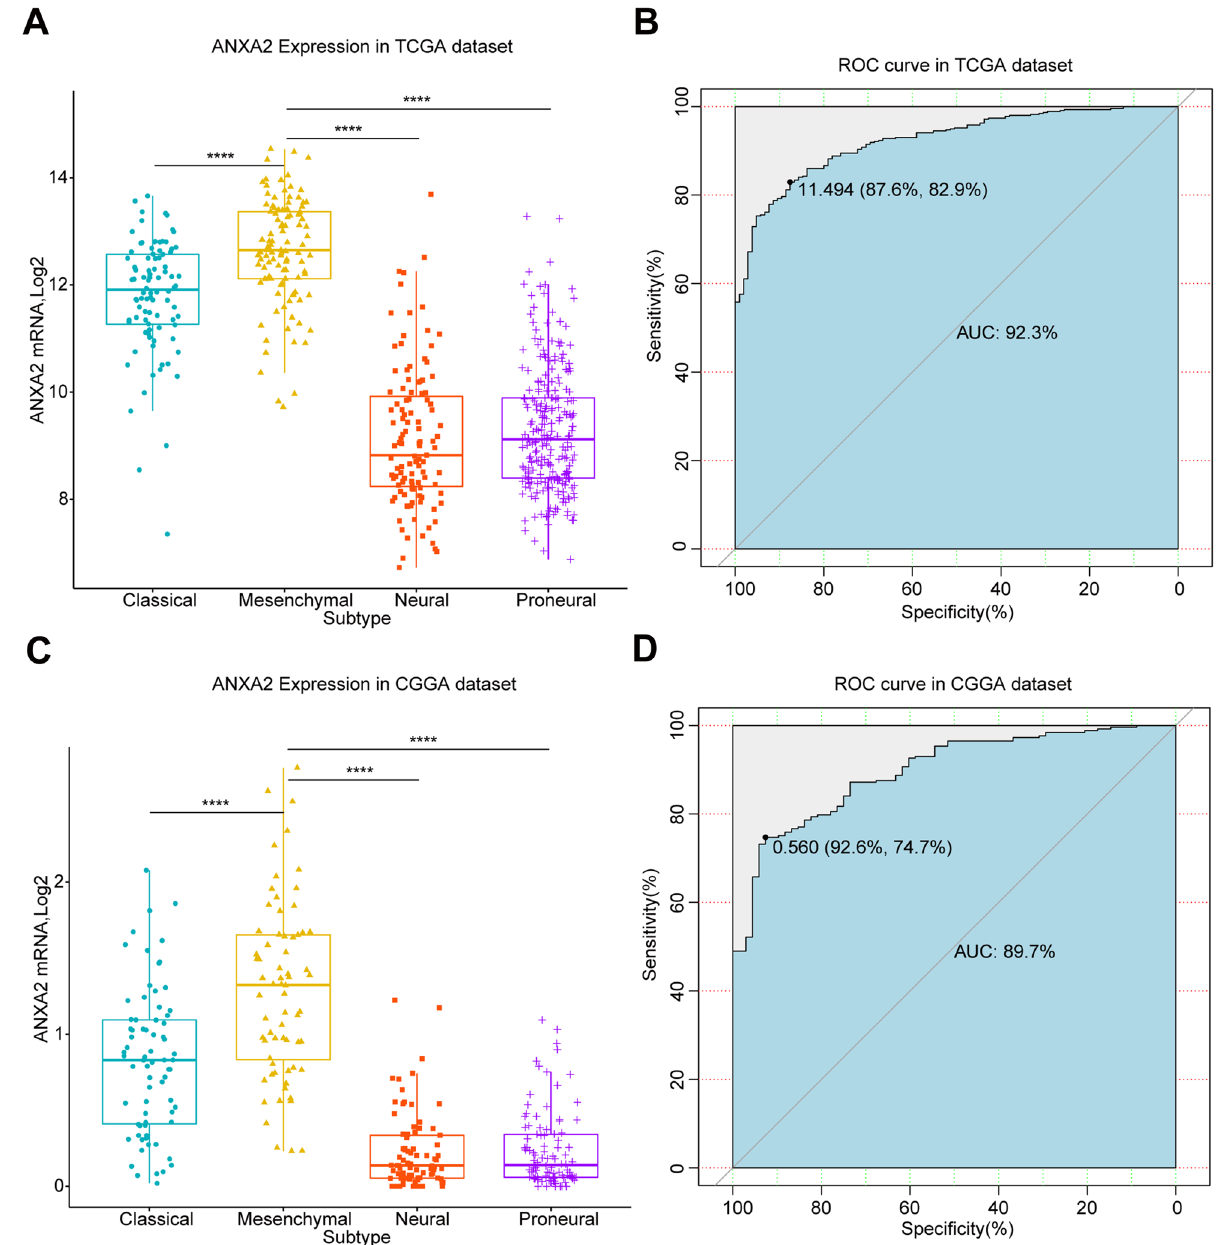
Figure 4. Comparison of ANXA2 expression levels in different TCGA molecular subtypes. ANXA2 was significantly enriched in the mesenchymal subtype in TCGA ( A ) and CGGA ( C ) cohorts ( P < 0.0001). ROC curve analysis showed the predictive value of ANXA2 for mesenchymal subtype in the TCGA and CGGA cohorts ( B,D ). *P < 0.05, **P < 0.01, ***P < 0.001, **** P < ated with ANXA2 were mainly involved in the GO terms cell adhesion, innate immune response and inflamma- tory response, leukocyte migration and interferon-gamma-mediated signalling pathway, positive regulation of I − kappa B kinase/NF − kappa B signalling, extracellular matrix organization and collagen degradation, angio- genesis and hypoxia reaction. In terms of molecular function, the genes associated with ANXA2 significantly acted on protein binding. In terms of cell components, ANXA2 mainly affects extracellular exosomes. The above conclusions were consistent across the TCGA and CGGA datasets (Fig. 5A,B). Furthermore, we performed GO functional analysis on the 419 related genes intersecting the two datasets intersecting and found similar results (Fig. 5C,D). Our results showed that ANXA2 plays an important role in the immunobiological processes of glioma patients. To determine the immune functions of ANXA2 in glioma, we downloaded immune system gene sets from the AmiGO 2 website. Then, the immune-related genes significantly related to ANXA2 were screened from the TCGA and CGGA databases (|R|> 0.6, P < 0.05). A total of 285 genes in the TCGA database and 199 genes in